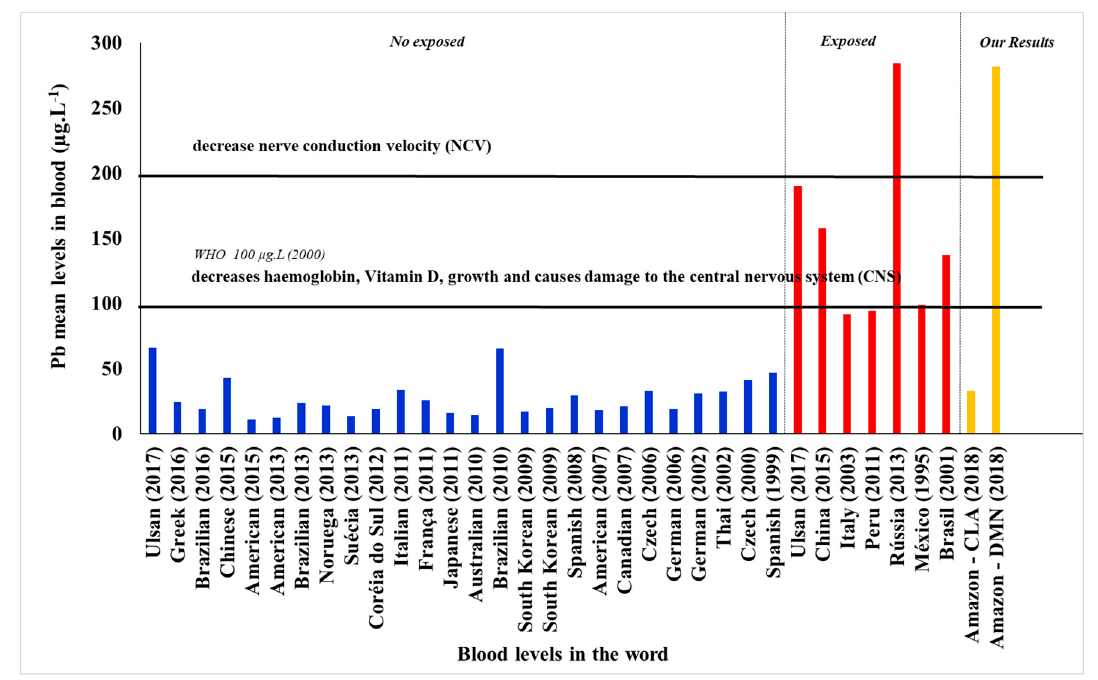
Figure A5. Mean levels of blood Pb in individuals living in the districts of Dom Manuel and Laranjal, and in individuals from other countries. Table A1. Mean levels of the total blood lead (Pb) in the districts of Dom Manuel and Laranjal, State of Pará, Brazil, 2012. Dom Manuel Laranjal